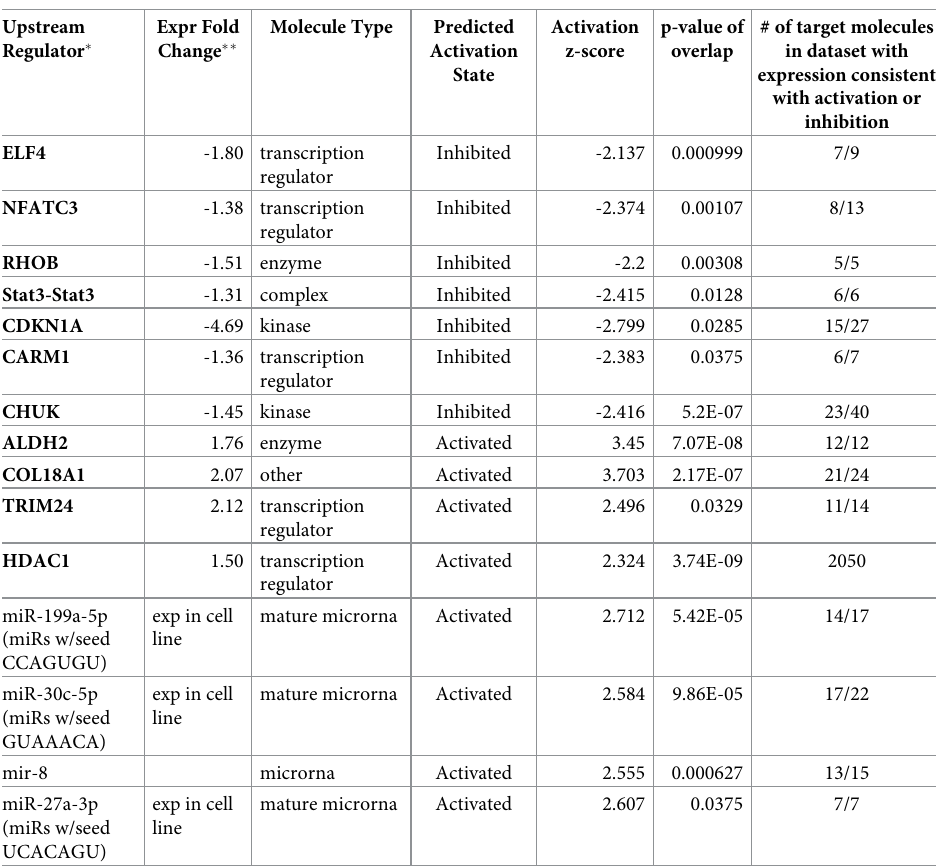
change with p < 0.05